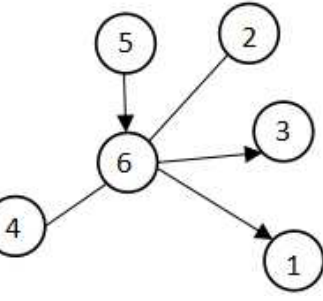
Figure 1. Disassembly hybrid graph.